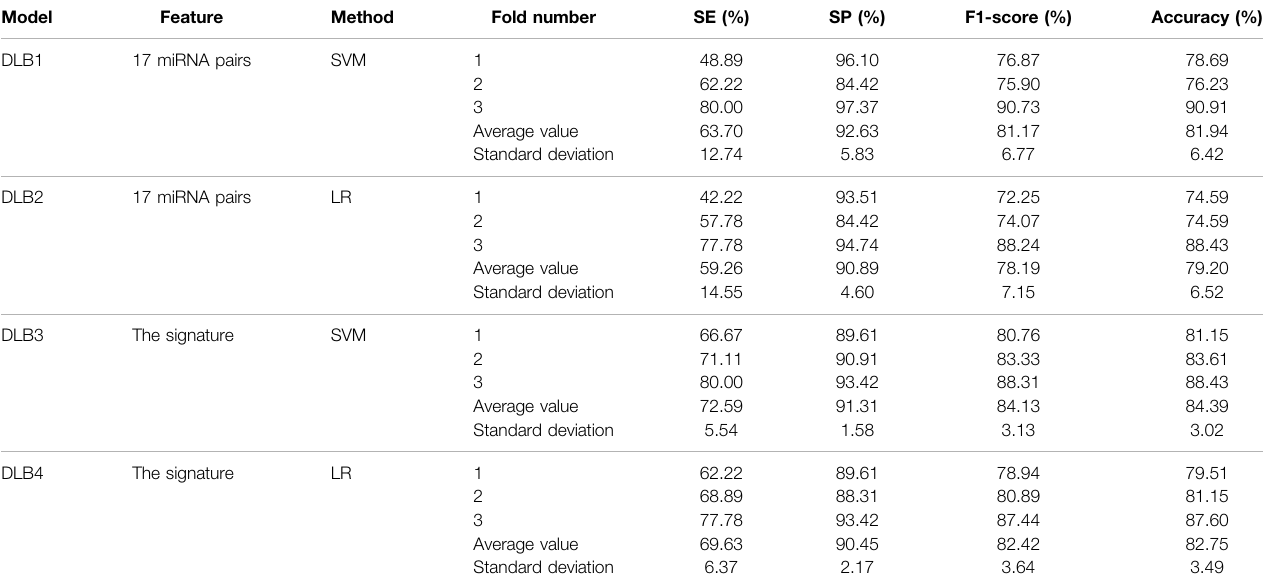
TABLE 4 | Prediction results of the strati fi ed 3-fold cross validation of four prediction models.